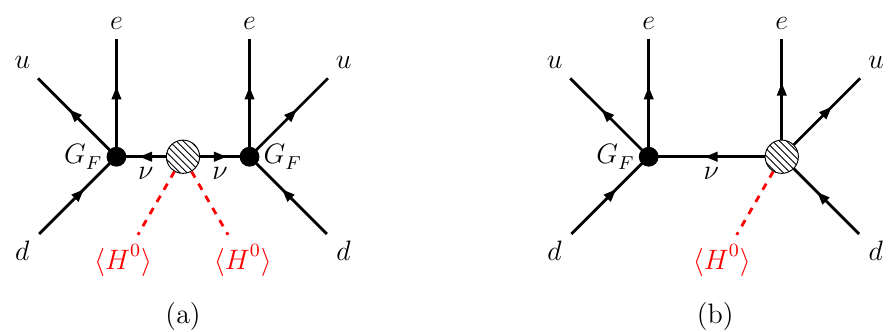
Figure 1 . The mass mechanism (left panel) and long-range contributions (right panel) to the 0 νββ decay rate, where the black dot denotes the SM effective four-fermion interaction, while the slashed circle stands for the effective vertex of the neutrino masses (left panel) and the long-range 0 νββ operator (right panel) arising from new physics. Here we do not show the diagram with two new physics vertices, since the corresponding contribution is